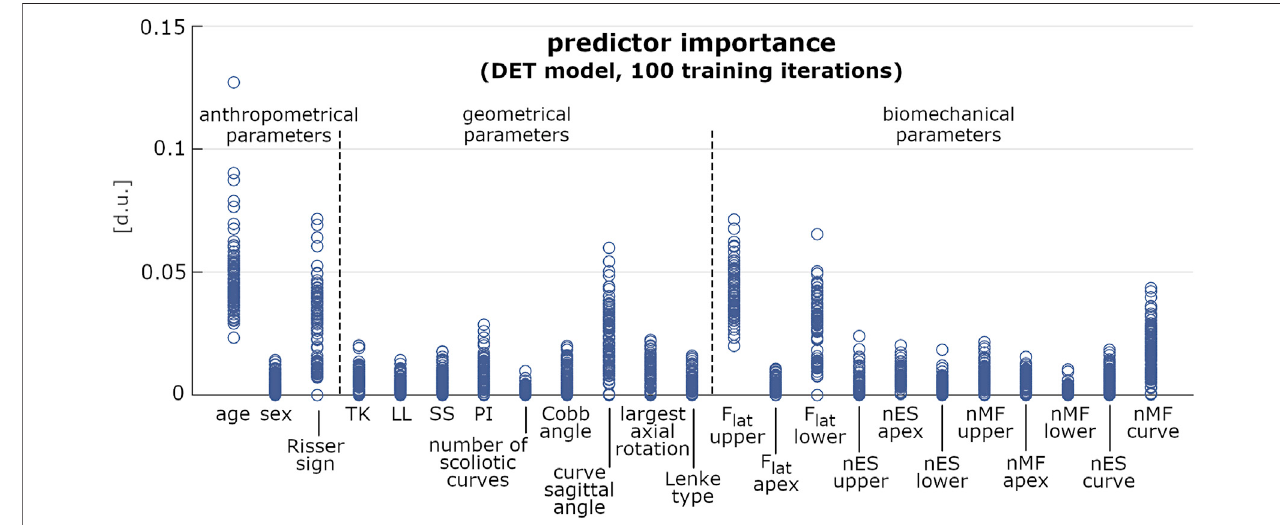
FIGURE 7 | Predictor importance (expressed in dimensionless units) of the anthropometrical, geometrical and biomechanical parameters, computed for 100 iterations of model training by DET approach. Each iteration accounted for 80 samples randomly chosen in the original dataset.